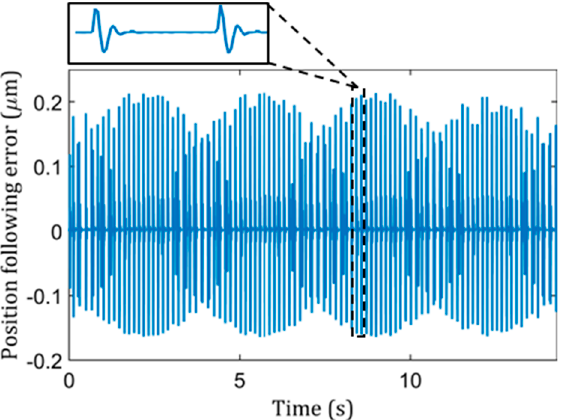
Figure 3. PMAC data acquired for position following error for the z-axis.